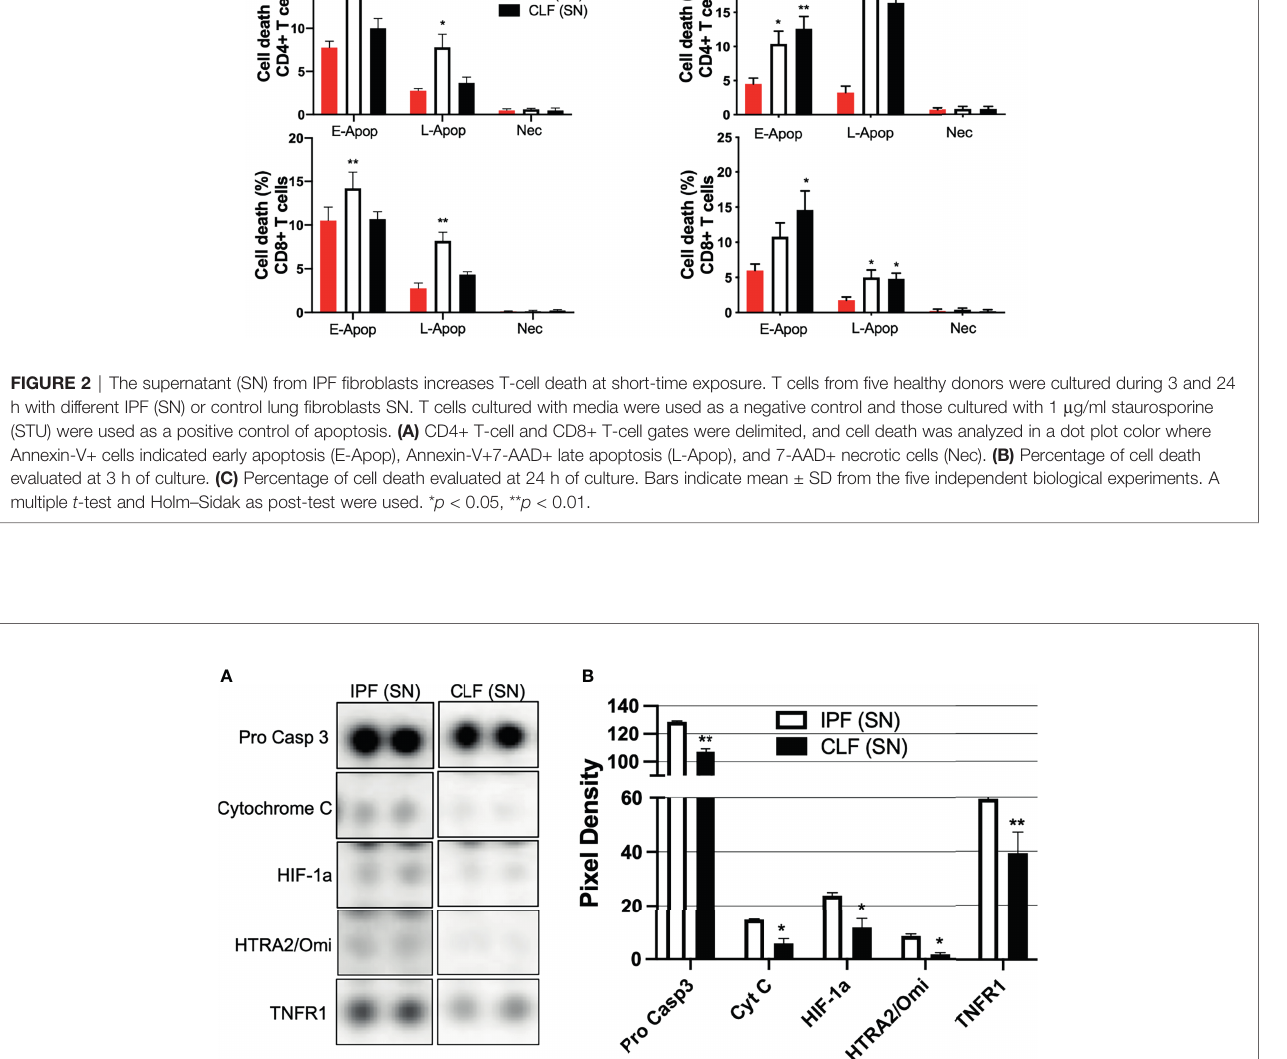
FIGURE 3 | The supernatant (SN) from IPF fi broblasts promotes a pro-apoptotic microenvironment. Fibroblast supernatants from two different IPF lungs and two healthy donors were recovered until having 360 m g/protein, then a Proteome Pro fi ler ™ kit was used. (A) Representative membrane for pro-caspase 3, cytochrome C, HIF-1a, HTRA2/Omi, and TNFR1. (B) Pixel density was obtained by densitometry using online ImageJ 1.39c software. Bars indicate mean ± SD from two independent experiments (two independent supernatants from IPF and CLF); each molecule was evaluated in duplicate. A Mann – Whitney U test was used. * p < 0.05, ** p < 0.01.